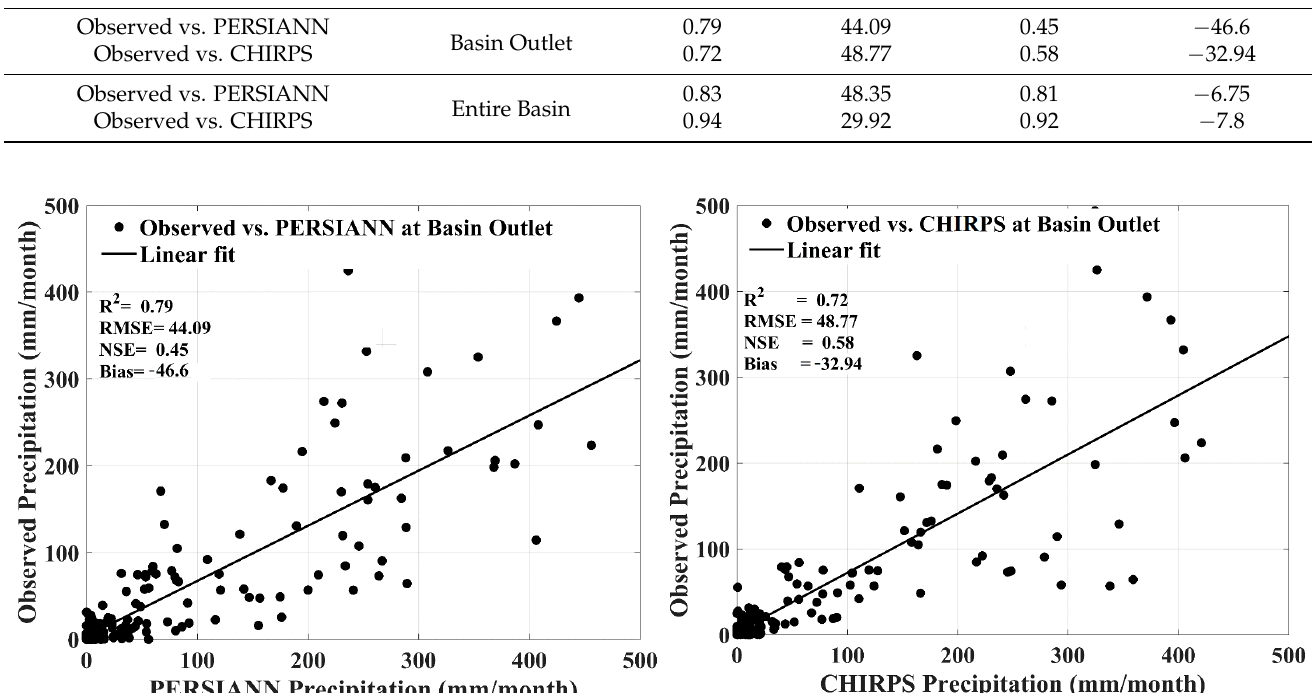
Figure 5. Scatter plots showing comparison of satellite precipitations (PERSIANN and CHIRPS) with the observed precipitation of single location at the outlet of the basin.